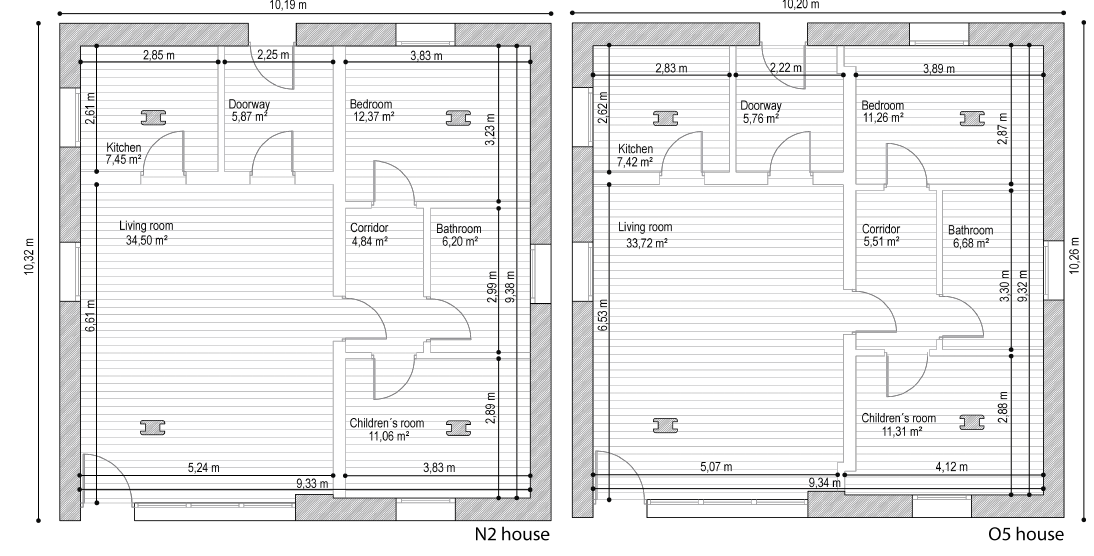
Figure 2. Plans of the